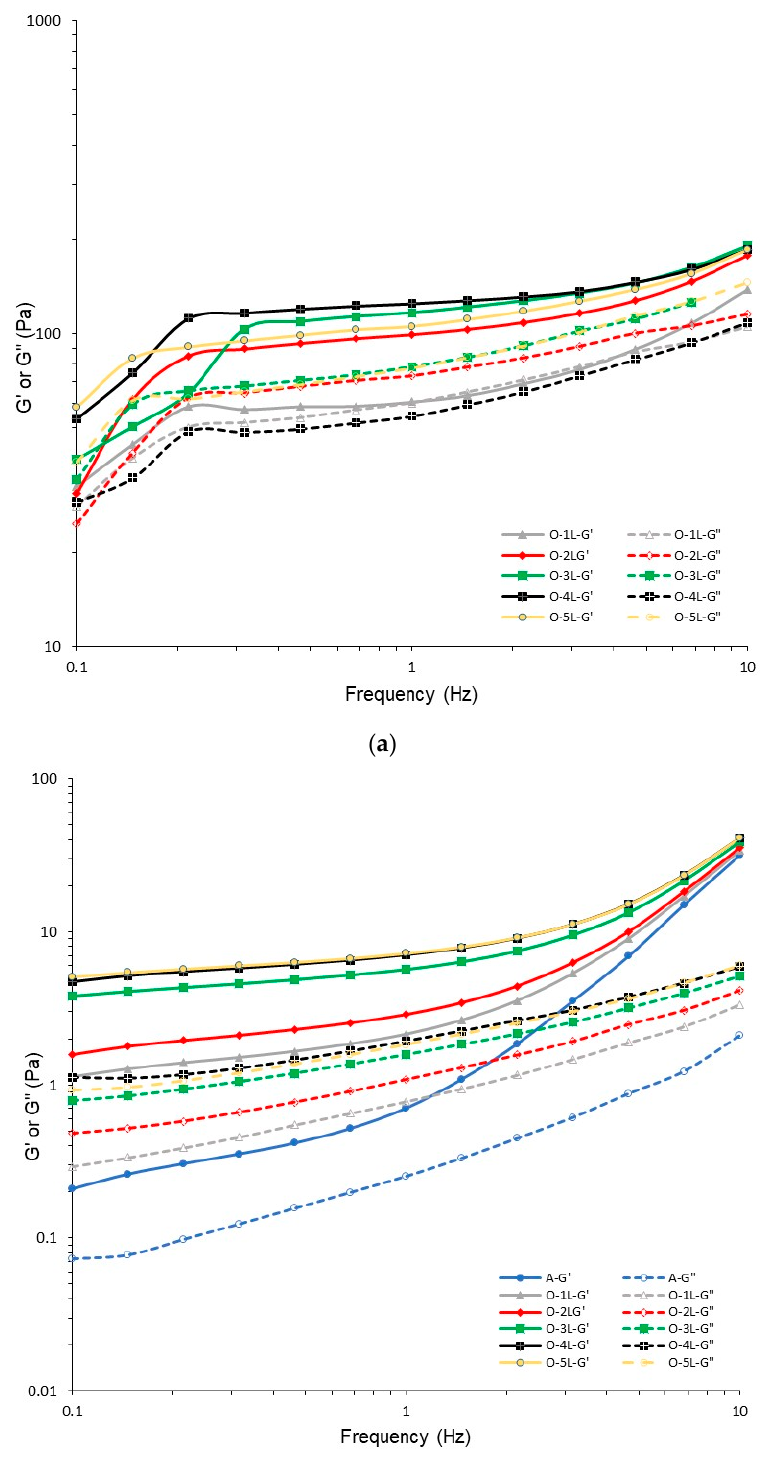
Figure 2. Frequency sweep curves of agar gel with different concentration of lecithin at temperatures of 4 ( a ) and 50 °C ( b ).